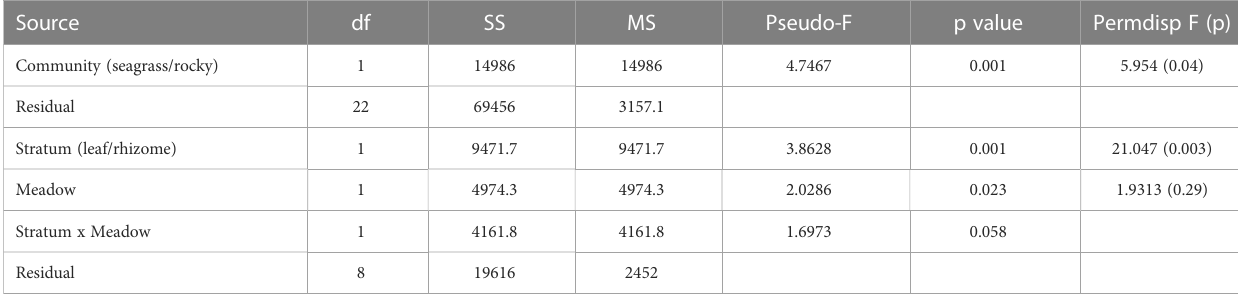
TABLE 1 Results of the PERMANOVA analyses considering the two main habitat types sampled and, for Posidonia oceanica samples, the effect of the stratum and meadow.